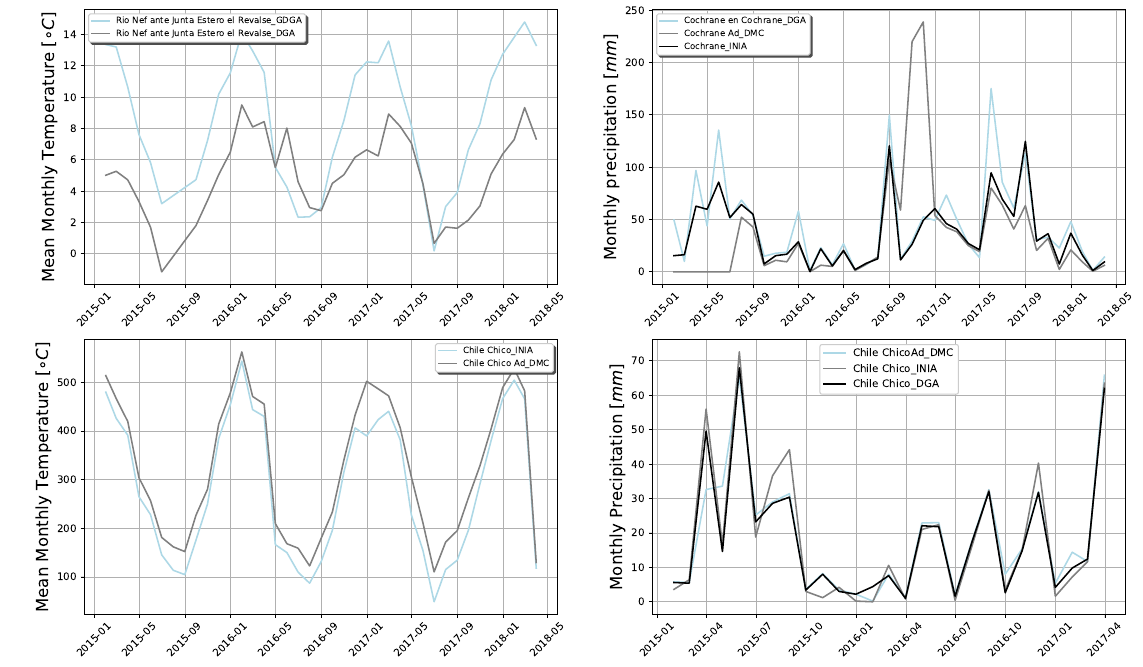
Figure 10. Repeated stations observing the same variable in the same location in the